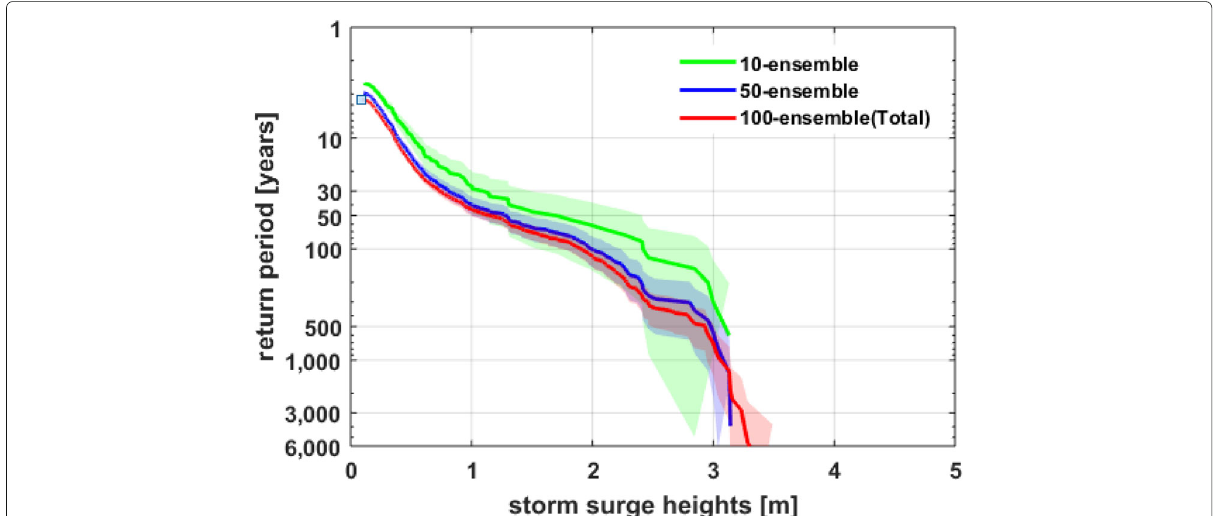
Fig. 10 Projection of future storm surge heights at Yeosu, Korea (10 ensembles: green, 50 ensembles: blue, 100 ensembles: red, shade indicates the 95% confidence intervals), based on d4PDF-R, after Yang et al. (2018)